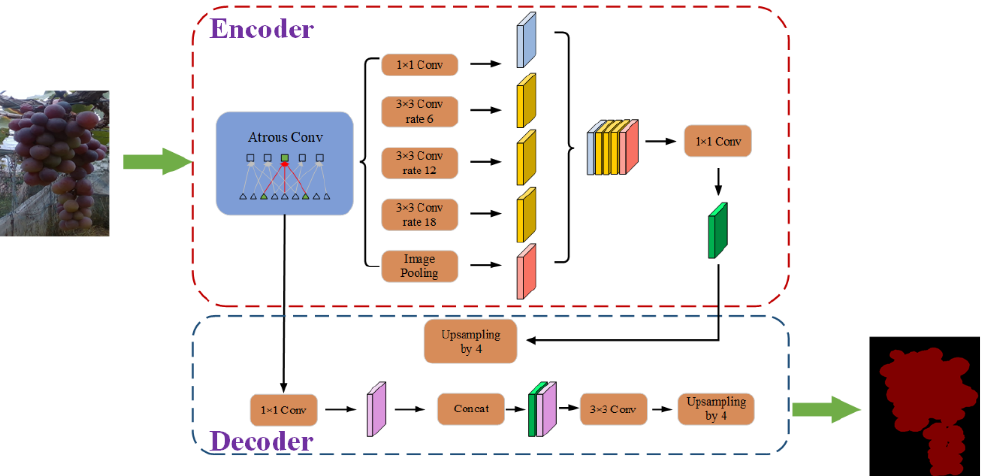
Figure 5. The structure of the DeepLabV3+ network.